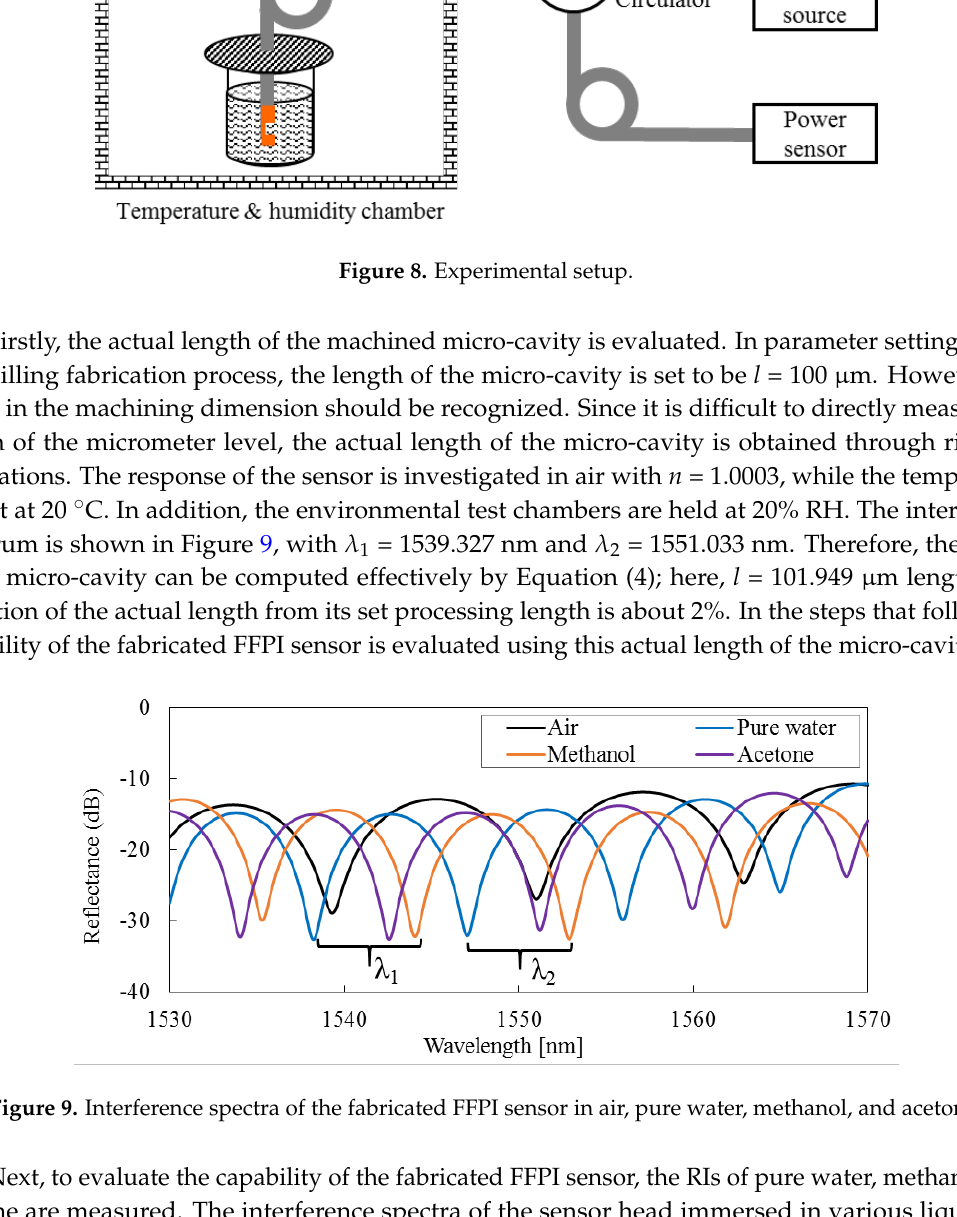
Table 1. Values of two adjacent interference minima and values of the RIs (at 20 °C)